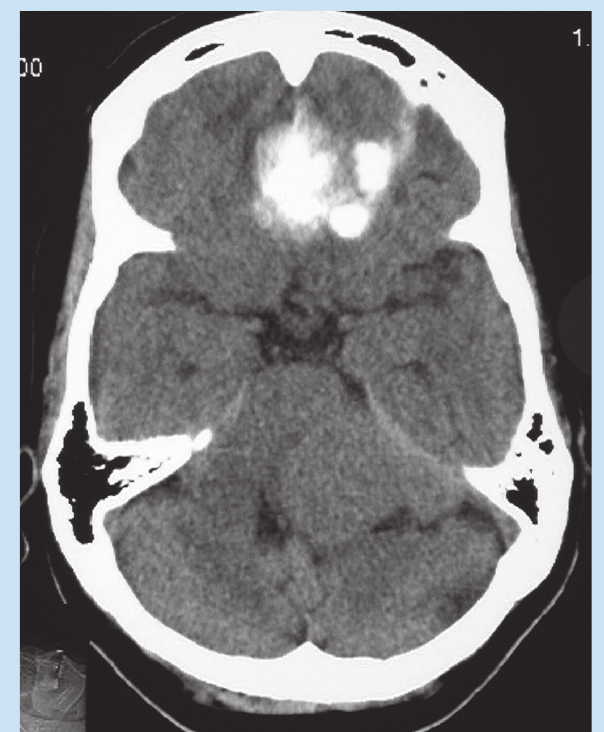
Fig. 2a. Pre-contrast image showing hyperdense parasagittal and left cerebellopontine angle meningiomas.